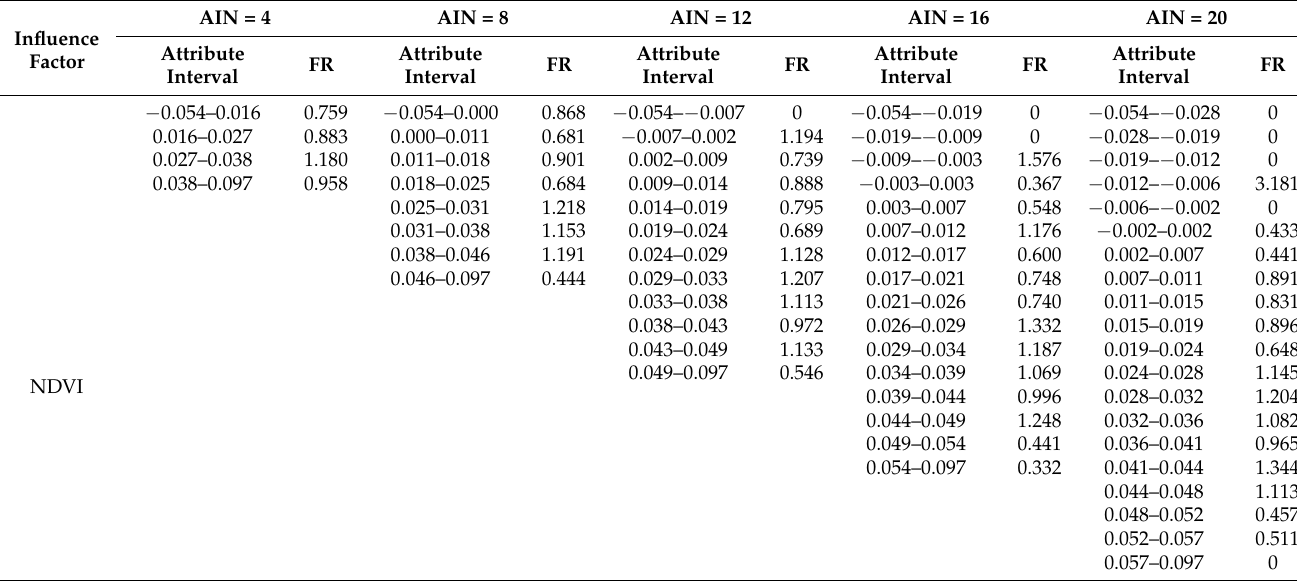
Table 4. FR of land cover and geological